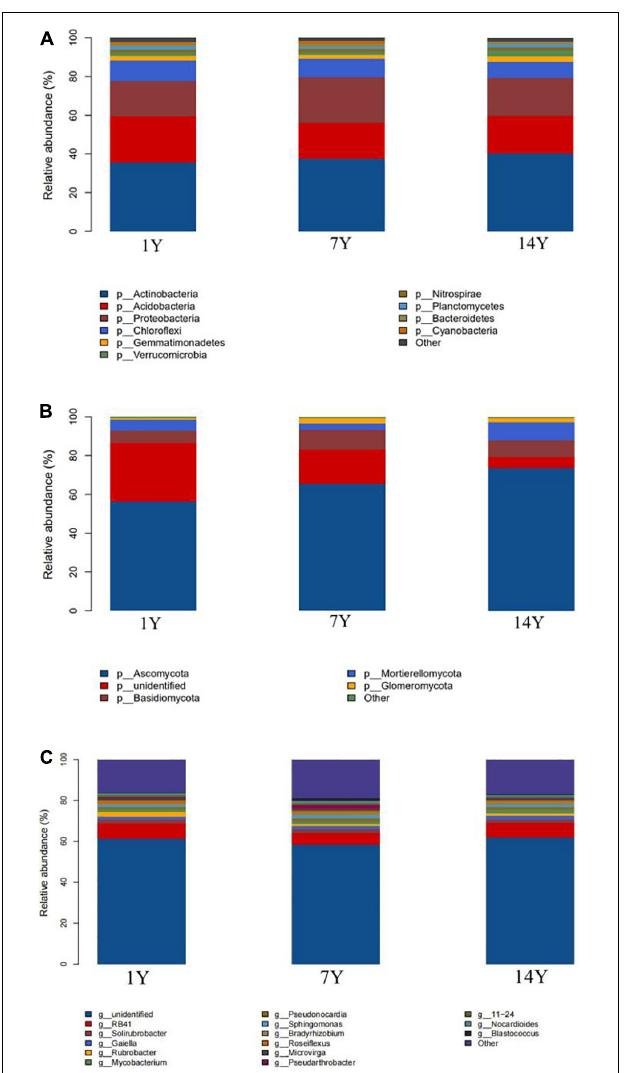
FIGURE 9 | The relative abundance (%) of continuous cropping of alfalfa rhizosphere soils, five repetitions per soil samples. (A) Major bacteria phylum, (B) major fungi phylum, (C) major bacteria